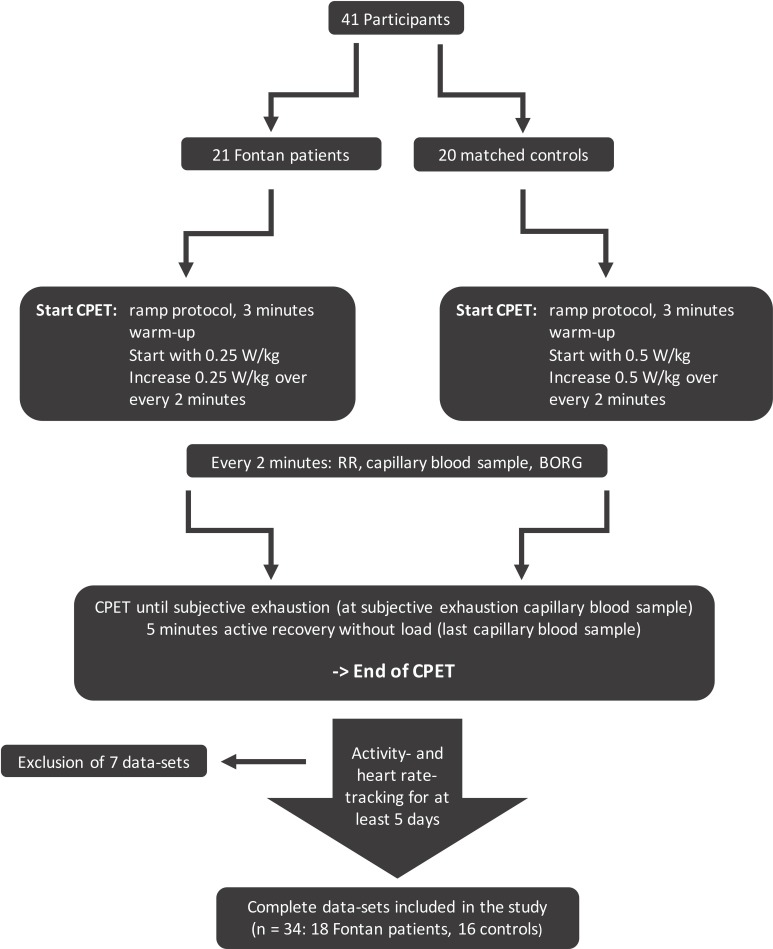
Study procedure and completed tests.